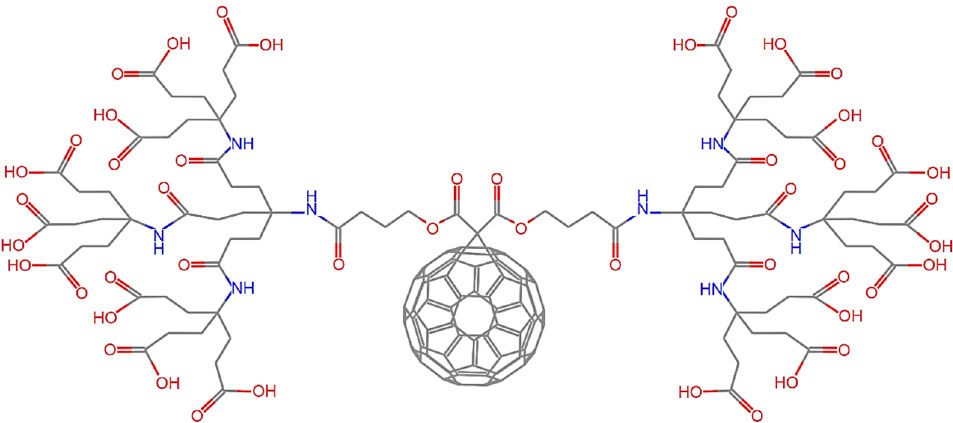
Figure 1. The chemical structure of the water-soluble dendro[60]fullerene.